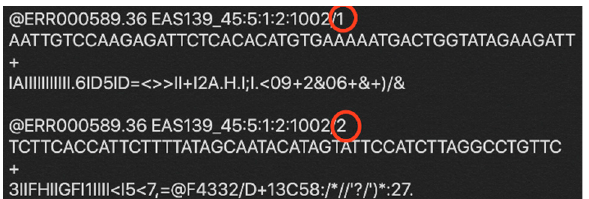
Figure 2. Example of paired-end reads. Four lines compose a read: (1) sequence identifier, (2) raw